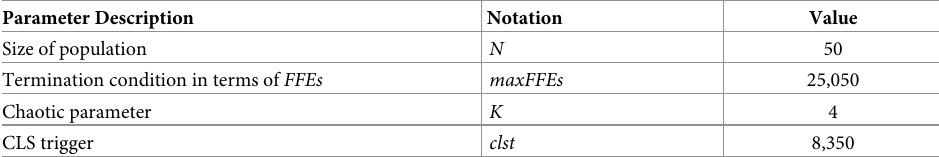
Table 2. COFFO control parameters.